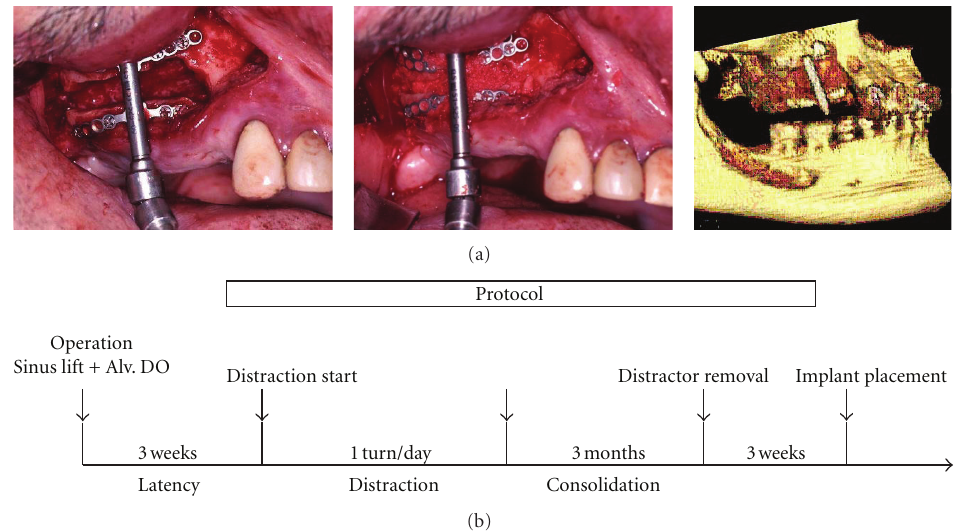
Figure 1: Surgical technique and treatment protocol for simultaneous sinus lifting and alveolar distraction. (a) Intraoperative views and 3D computed tomography of the result; (b) treatment protocol for simultaneous sinus lifting with alveolar distraction and implant placement.